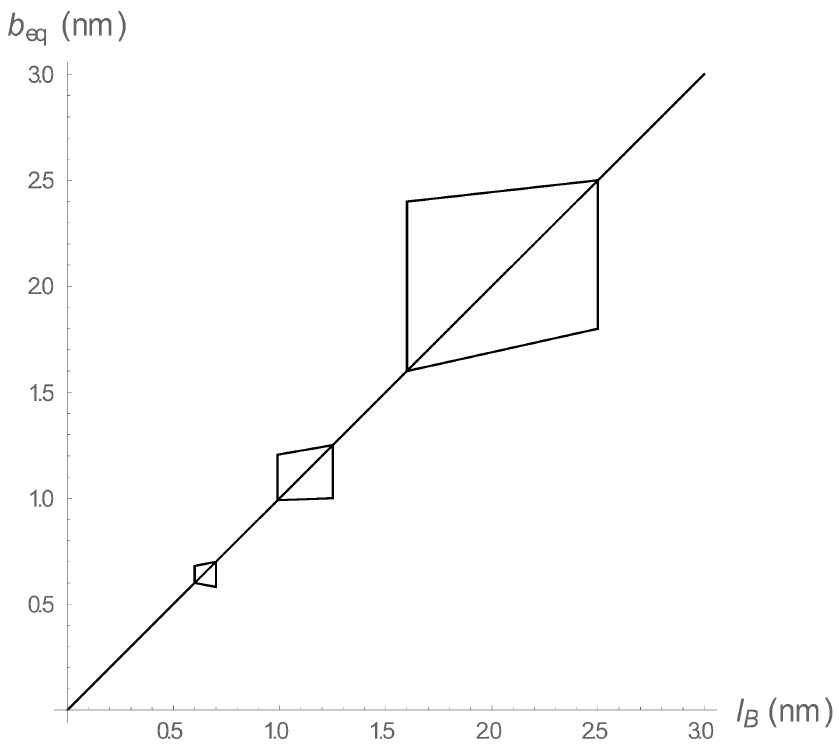
Figure 4. The fluctuation regime near the counterion condensation threshold. The three regions shown are, from left to right, for spring constants a = 5.0, 1.0, 0.1, all in (nm) − 2 . See text for further